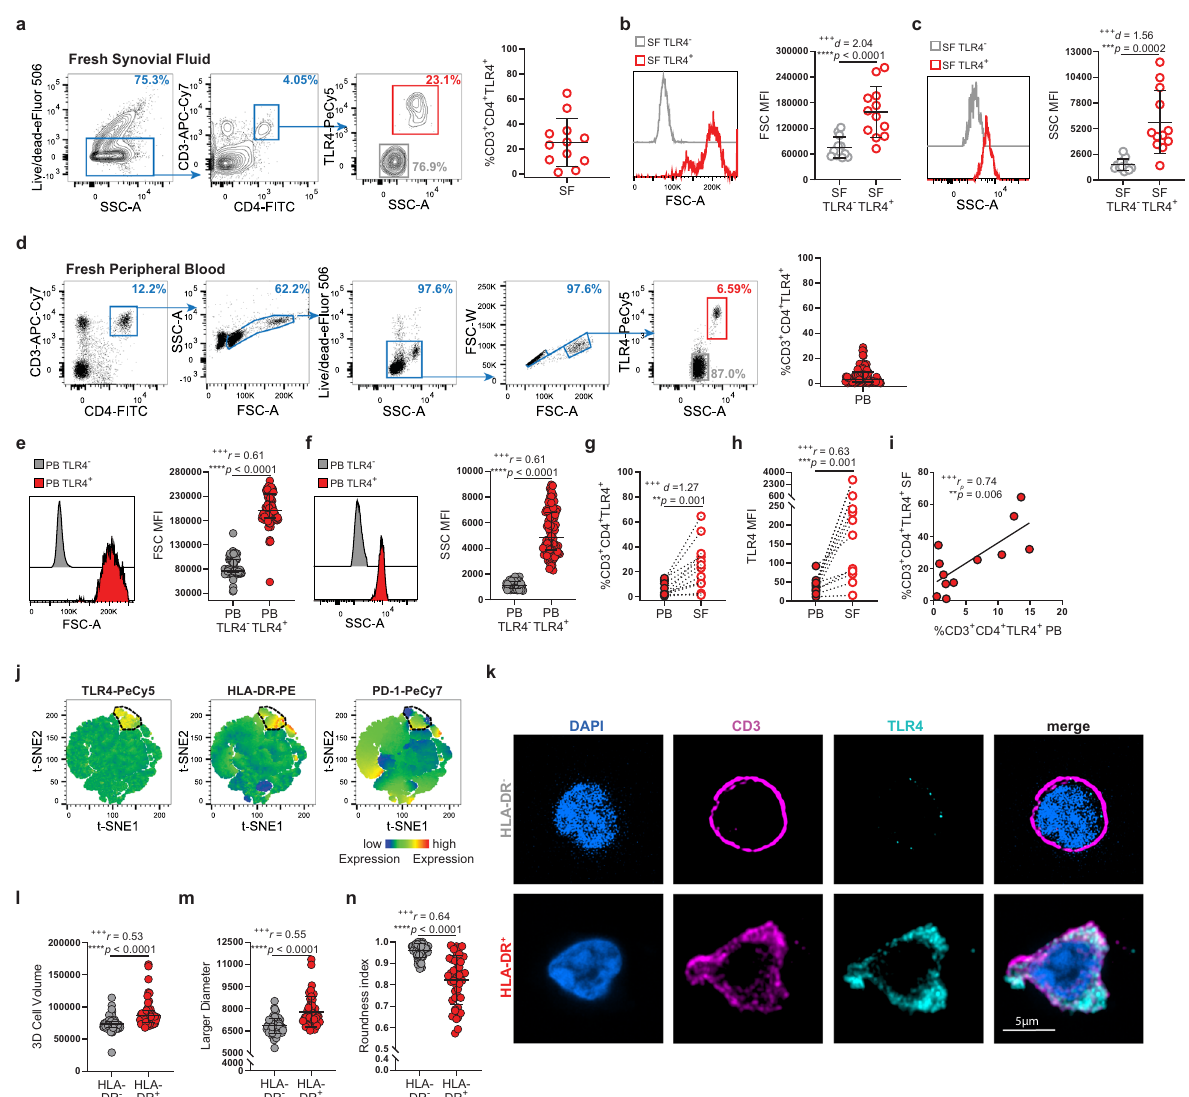
Fig. 1 RA patients display a circulating TLR4 + T-cell population that is expanded in the synovial fl uid. a Gating strategy and cumulative frequency of CD3 + CD4 + TLR4 + cells in freshly obtained synovial fl uid ( n = 12 RA patients). b Representative histogram and cumulative plot of relative cell size (FSC-A) in TLR4 − (gray) and TLR4 + (red) synovial fl uid T cells ( n = 12 RA patients). c Representative histogram and cumulative plot of relative cell complexity (SSC-A) of TLR4 − (gray) and TLR4 + (red) synovial fl uid T cells ( n = 12 RA patients). d Gating strategy and cumulative frequency of CD3 + CD4 + TLR4 + cells in freshly obtained peripheral blood ( n = 100 RA patients). e Representative histogram and cumulative plot of relative cell size (FSC-A) in TLR4 − (gray) and TLR4 + (red) peripheral blood T cells ( n = 100 RA patients). f Representative histogram and cumulative plot of relative cell complexity (SSC-A) of TLR4 − (gray) and TLR4 + (red) peripheral blood T cells ( n = 100 RA patients). g Donor-matched analysis of the frequency of TLR4 expression by CD3 + CD4 + T cells in peripheral blood (closed circles; PB) and in synovial fl uid (open circles; SF) ( n = 12 RA patients). h Donor-matched analysis of the MFI of TLR4 expression by CD3 + CD4 + T cells in peripheral blood (closed circles; PB) and in synovial fl uid (open circles; SF) ( n = 11 RA patients). i Correlation between the frequency of CD3 + CD4 + TLR4 + T cells in the blood (PB) and in synovial fl uid (SF) ( n = 12 RA patients). j t-SNE plots of peripheral blood total CD4 + T cells. The color indicates cell expression levels of labeled markers (TLR4, HLA-DR, and PD-1). Circle demarks TLR4 + cells ( n = 26 RA patients). k – n Confocal microscopy of FACS-puri fi ed HLA-DR − and HLA-DR + CD4 + T cells. k Cells were surface labeled for CD3 and TLR4, stained for DAPI, and analyzed by 3D confocal microscopy. Bar, 5 μ m. l Cumulative graphs of 3D volume ( n = 76 HLA-DR − CD4 + T cells; n = 47 HLA-DR + CD4 + T cells); m larger diameter ( n = 76 HLA-DR − CD4 + T cells; n = 47 HLA-DR + CD4 + T cells), and n roundness index ( n = 75 HLA-DR − CD4 + T cells; n = 44 HLA-DR + CD4 + T cells). Data are presented as mean ± SD, for parametric statistical tests, or median ± IQR, for non-parametric statistical tests. Sample normality distribution was tested by using D ’ Agostino & Pearson normality test. P values **** p ≤ 0.0001, *** p ≤ 0.001, ** p ≤ 0.01, * p ≤ 0.05 were determined by ( b , c , g ) Paired t test; ( e , f , h ) Wilcoxon matched-pairs rank test; ( i ) Pearson Correlation and ( l – n ) Mann – Whitney test. Effect size measures +++ high, ++ medium, + small were determined by ( b , c , g ) d – Cohen ’ s d; ( e , f , h , l – n ) r – correlation coef fi cient r, and ( i ) r – Pearson ’ s correlation p coef fi